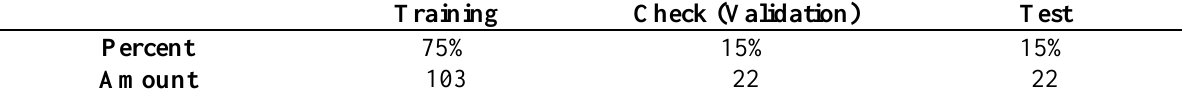
Distribution of Data into three subsets of Training, Check (Validation), and Test steps.